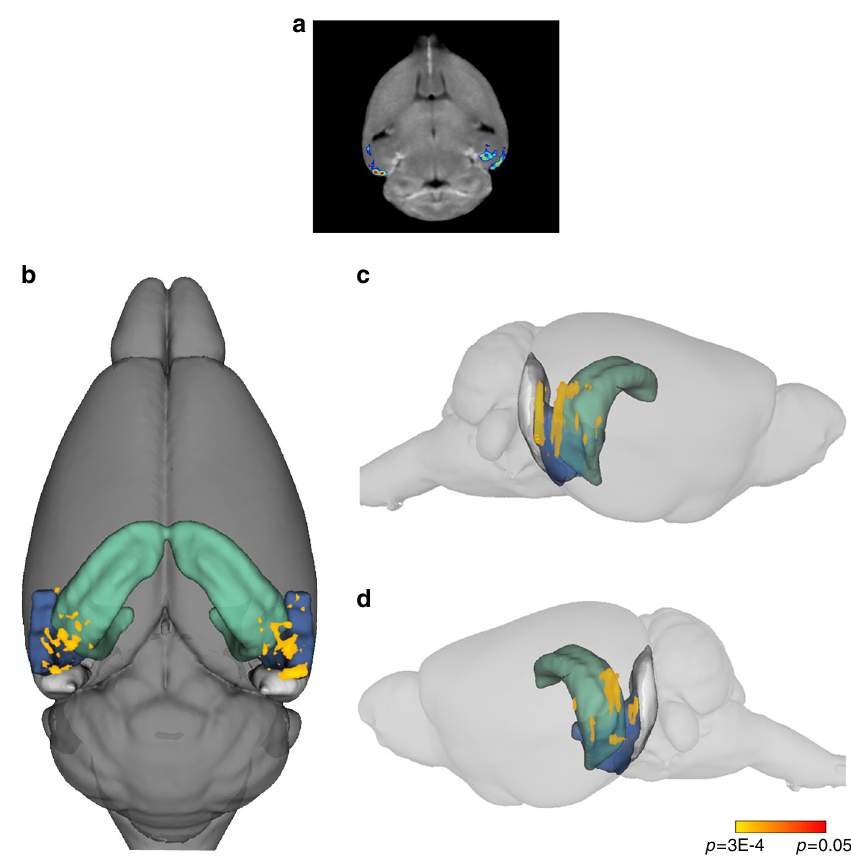
Fig. 1 APOE4 is associated with entorhinal cortex hypermetabolism in aged mice. fMRI analysis was performed on aged APOE mice (mean age = 20 months; 7 APOE3 and 8 APOE4 males), and a voxel-based analysis was performed to generate CBV maps of the whole brain of each mouse, followed by co-registration of each image, ROI selection of the hippocampal formation, and statistical comparison between genotypes by a Student ’ s t test, followed by multiple test correction. a Voxel-based analyses revealed that aged APOE4 mice had increased CBV in the hippocampal formation compared with APOE3 mice, primarily centered around the EC. b 3D superior view of CBV increase detected in aged APOE4 vs. APOE3 mice, as indicated using a heat scale by p value. c Right sagittal view of the same analysis. d Left sagittal view of the same analysis. For each panel, the colored regions depict the hippocampus and subiculum in green, the lateral entorhinal cortex (LEC) in blue, and the medial entorhinal cortex (MEC) in